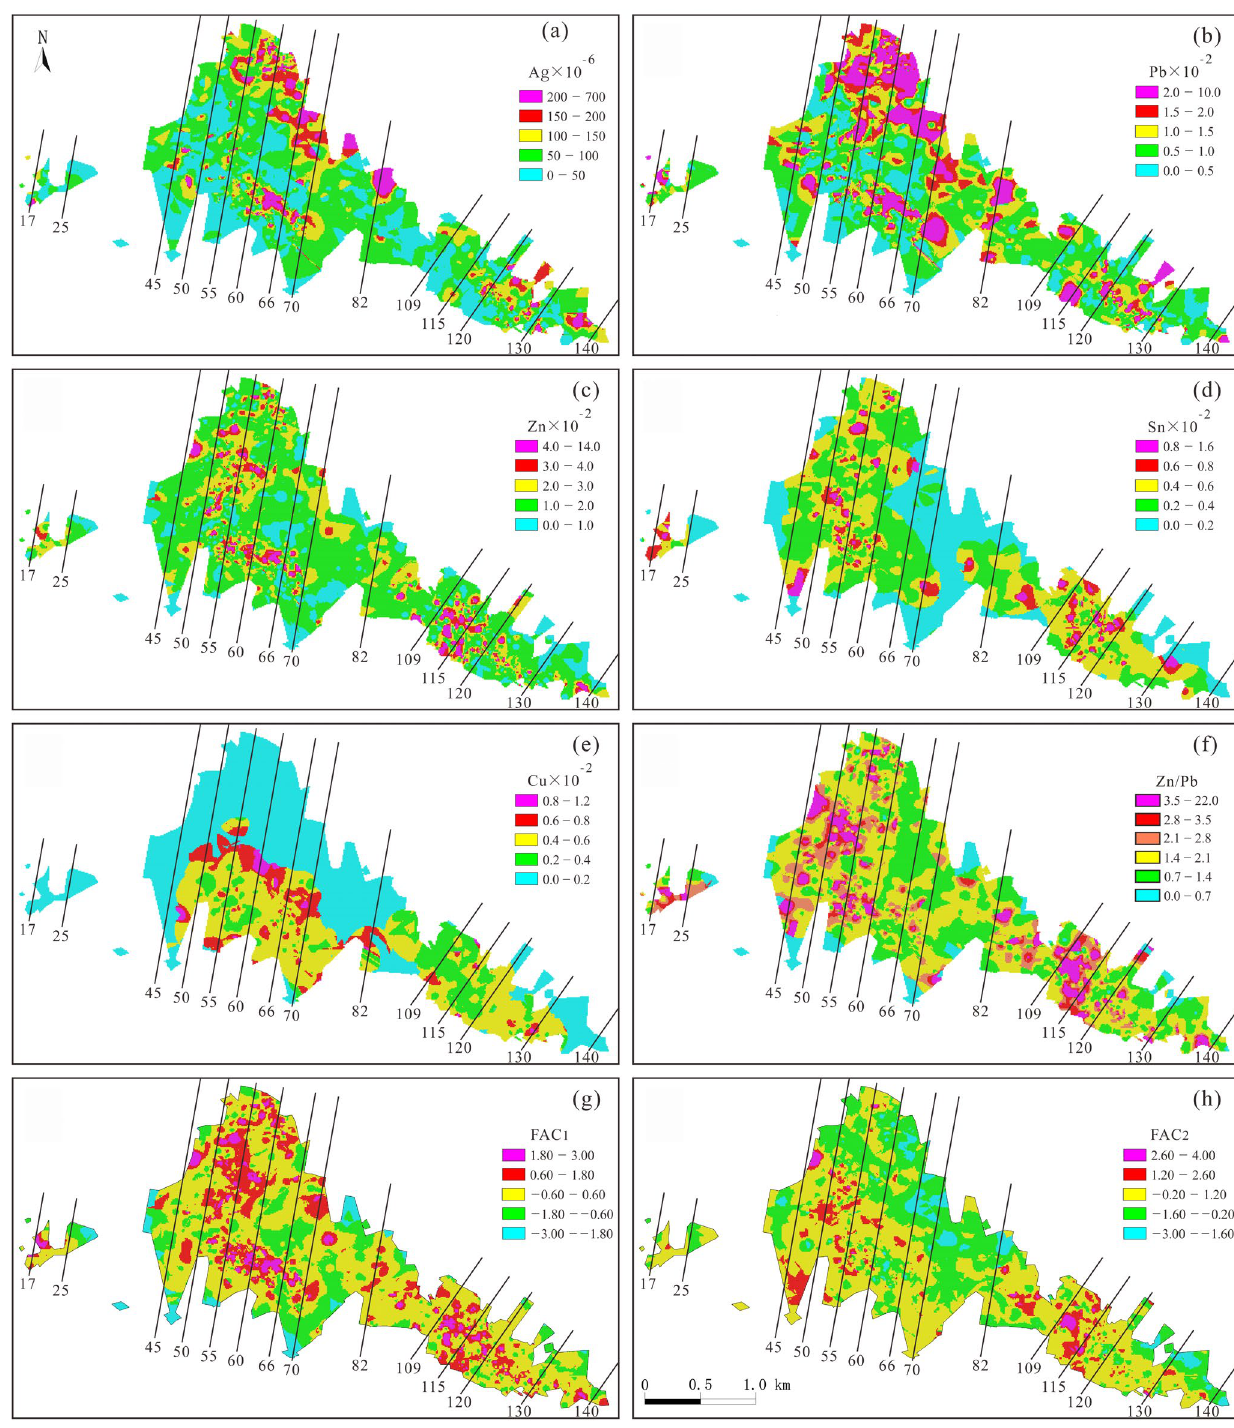
Figure 10. Horizontal projection of the ore grades and distribution of mineralization: ( a ) Ag; ( b ) Pb; ( c ) Zn; ( d ) Sn; ( e ) Cu; ( f ) Zn/Pb; ( g ) FAC 1 = medium-temperature factor score; ( h ) FAC 2 = high- temperature factor